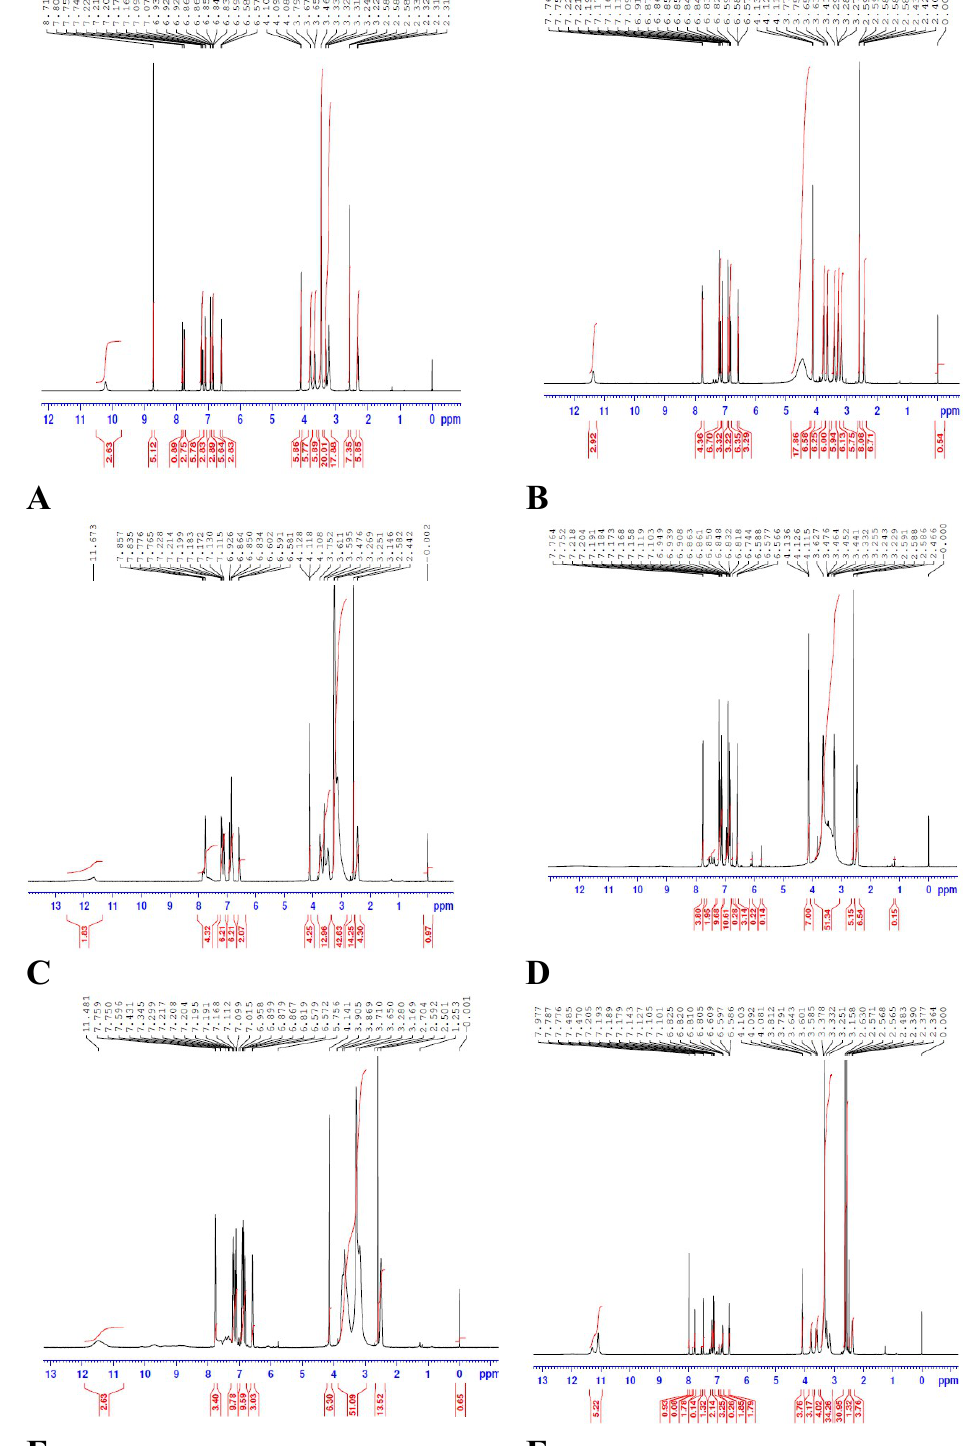
Figure 6. 1 HNMR spectra of the TZD drug with the six π-acceptors; ( A ): PA, ( B ): DDQ, ( C ): TCNQ, ( D ): DCQ, ( E ): DBQ, and ( F ): NBS. TZD and π-receptor interactions result in n-π* transitions and form the pairs of rad- ical ions (the D +. radical cation and the A − radical anions). In the presence of the six recep- tors, conductivity values for TZD were measured, and a modest increase was observed.